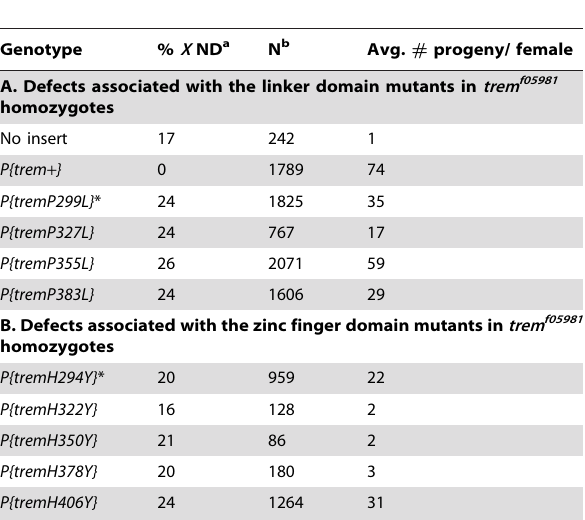
Due to the enrichment of Trem in cells located just prior to the start of meiotic prophase and previously published data that trem F9 is defective in meiotic recombination [13]; we further analyzed the effect on recombination in trem F9 females along the X chromosome (Table 3). Recombination across the entire euchromatic region was reduced in a relatively uniform fashion, which is to say that trem does not exhibit an altered distribution in the residual crossovers that do occur. An examination of 2 nd chromosome recombination in trem F9 females revealed a similar reduction to that observed on the X chromosome. Exchange was reduced to 11.1% of wild type across the left arm of chromosome 2 , and no changes in the exchange distribution on this chromosome were